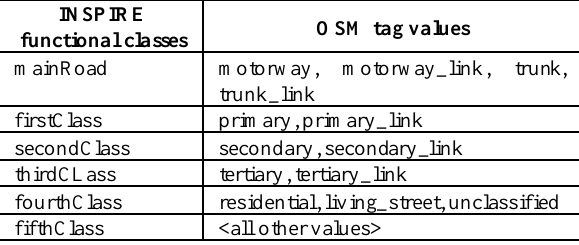
Table 3 - Correspondences between INSPIRE road functional classes and OSM tag values.